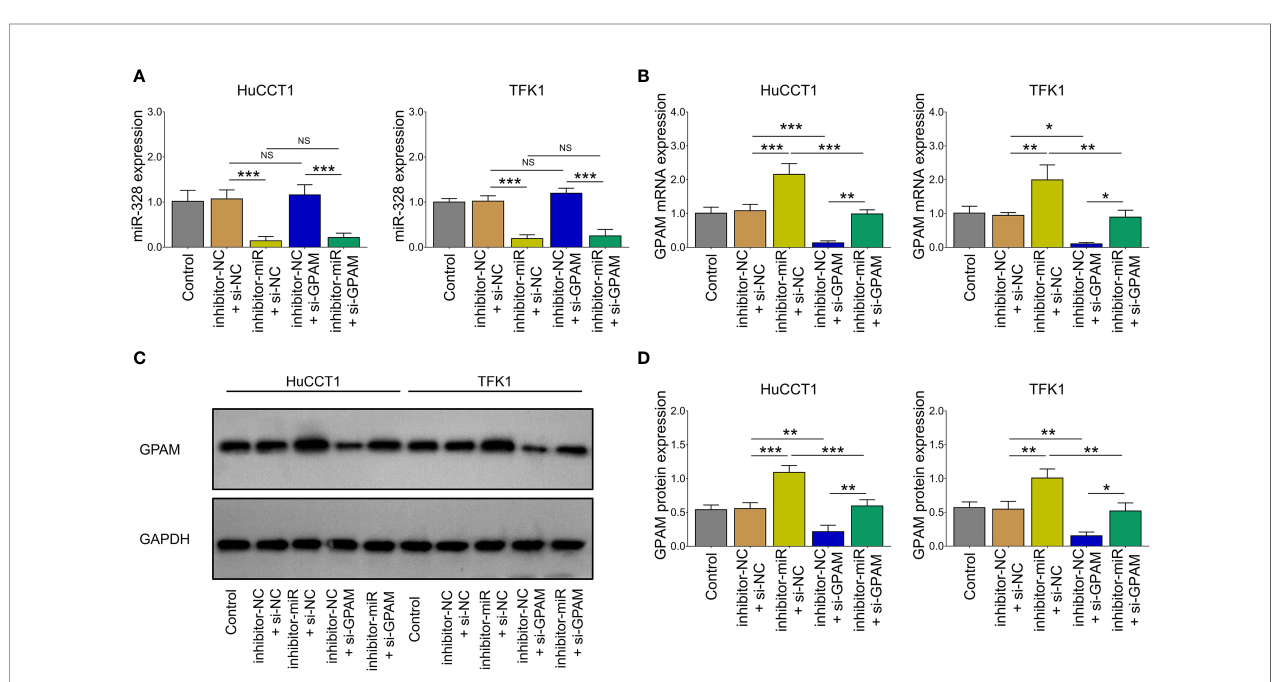
FIGURE 6 | miR-328 and GPAM expressions after their siRNA/inhibitor transfection in CCA cell lines. miR-328 expression (A) and GPAM expression (B – D) among groups after transfection. NS, not signi fi cant; * P < 0.05; ** P < 0.01; *** P <